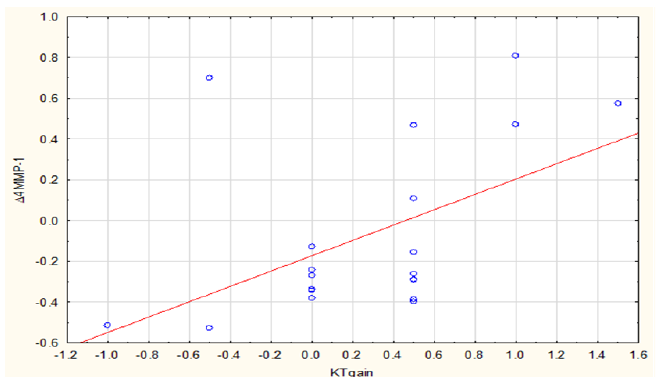
Figure 4. Correlation between ∆ 4MMP-1 (3M-0) and KTgain after CM.